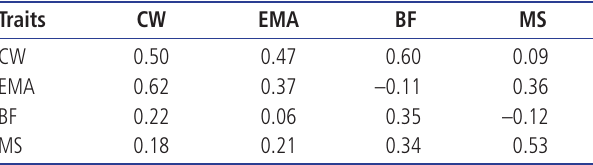
Table 8. Heritabilities (diagonal), genetic correlations (upper diagonal), and phenotypic correlations (lower diagonal) of carcass traits in Chikso Traits